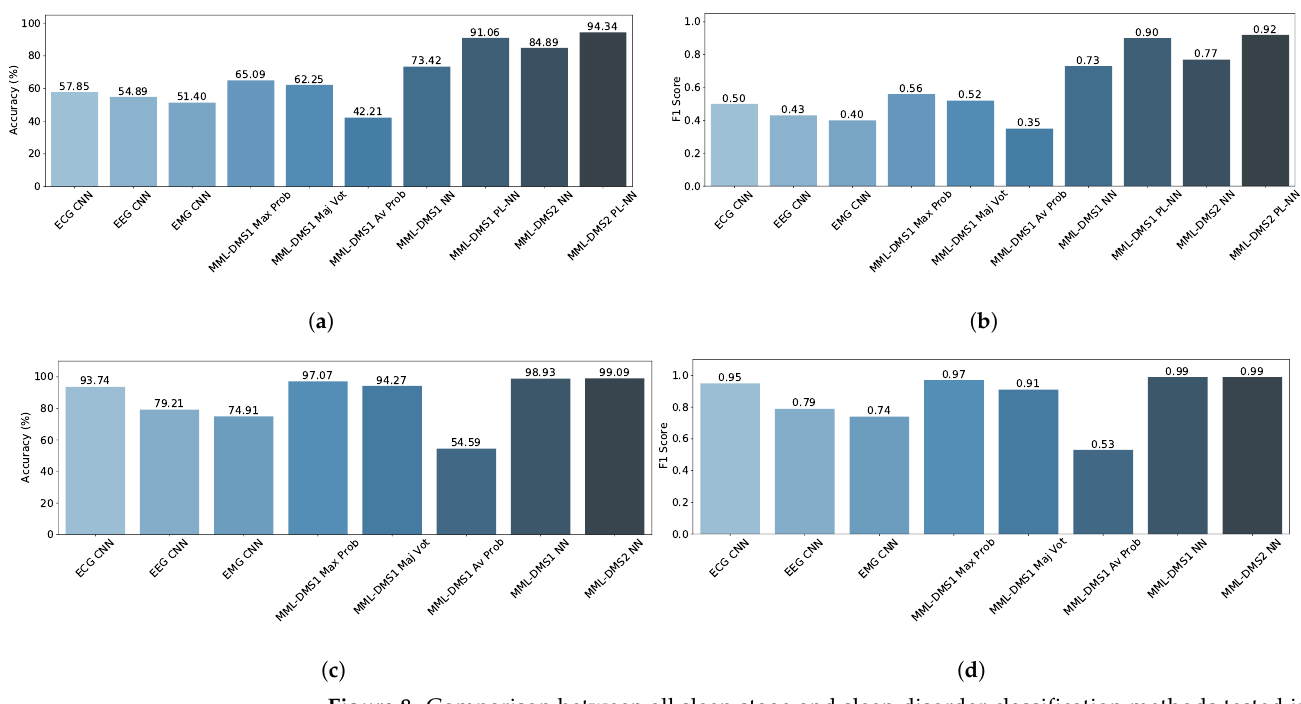
Figure 8. Comparison between all sleep stage and sleep disorder classification methods tested in this study: ( a ) Accuracy (%)—Sleep Stage Recognition; ( b ) F 1 Score (%)—Sleep Stage Recognition; ( c ) Accuracy (%)—Sleep Disorder Recognition; ( d ) F 1 Score (%)—Sleep Disorder Recognition. The experiments demonstrated a clear advantage of combining not only the multi- modal but also the multilabel information. It was confirmed by the highest performance resulting from the MML-DMS2 approach, which outperformed all other techniques and led to a 94.34% classification accuracy for the sleep stage recognition and 99.09% for the sleep disorder recognition. The F 1 scores and the confusion matrices were also consistently high, showing that the proposed modular system of networks has the capacity to compensate for the training data imbalance and give uniformly high recognition accuracy across all data categories. The second-best performance was achieved by the MML-DMS1 method offering a fusion of modalities but not the labels. It led to slightly lower classification accuracy values, i.e., 91.06% for sleep stage and 98.93% for sleep disorder classification. The highest difference was observed for the least-performing single-modality and single-label techniques. The CNN classifiers using EEG or EMG signals alone achieved around 51% to 55% accuracy for the sleep stage and about 75% to 79% for the sleep disorder